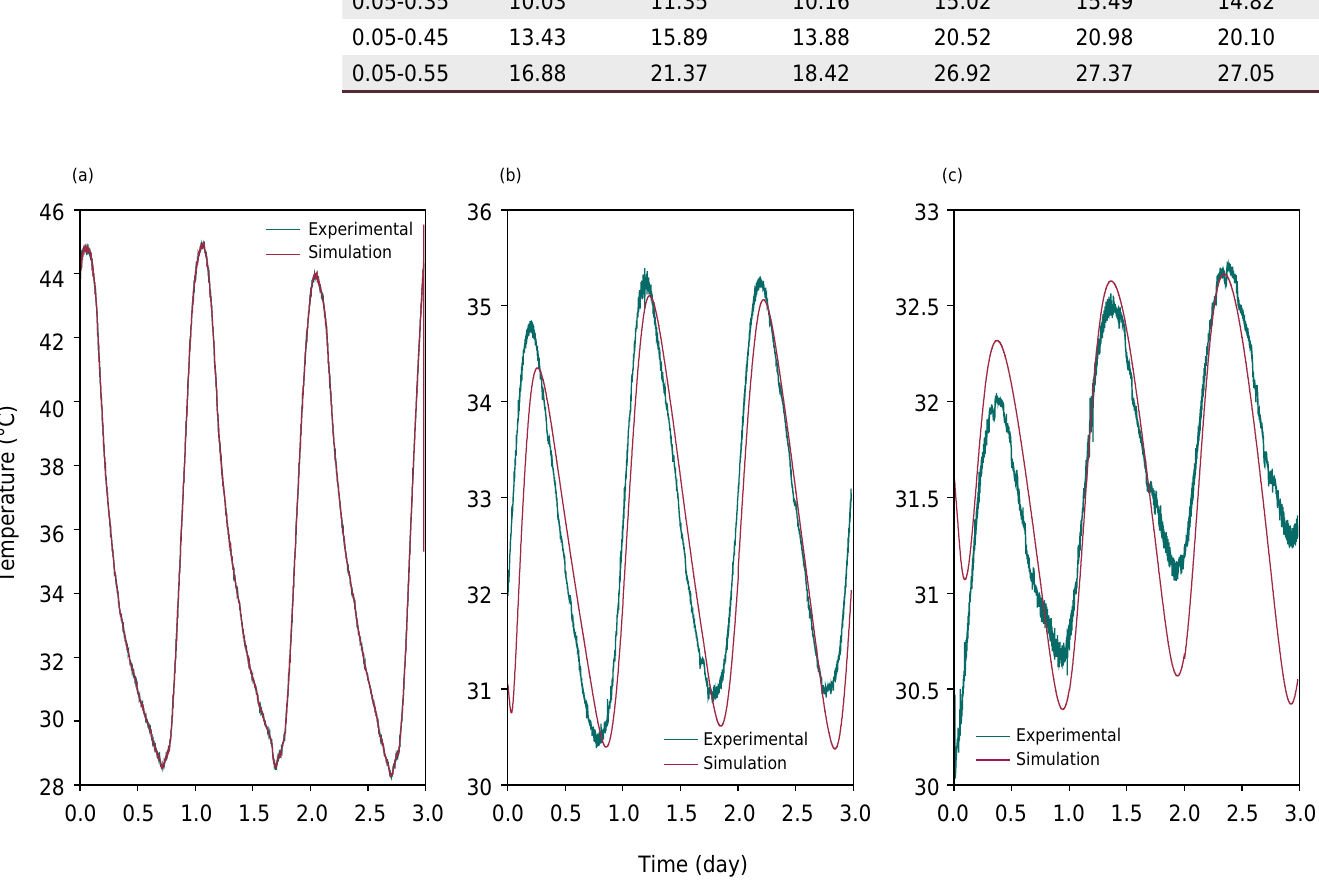
Time Figure 7. Comparison of theoretical and experimental variation of temperature (a) z = 0.05 m, (b) z = 0.15 m, (c) z = 0.25 m.